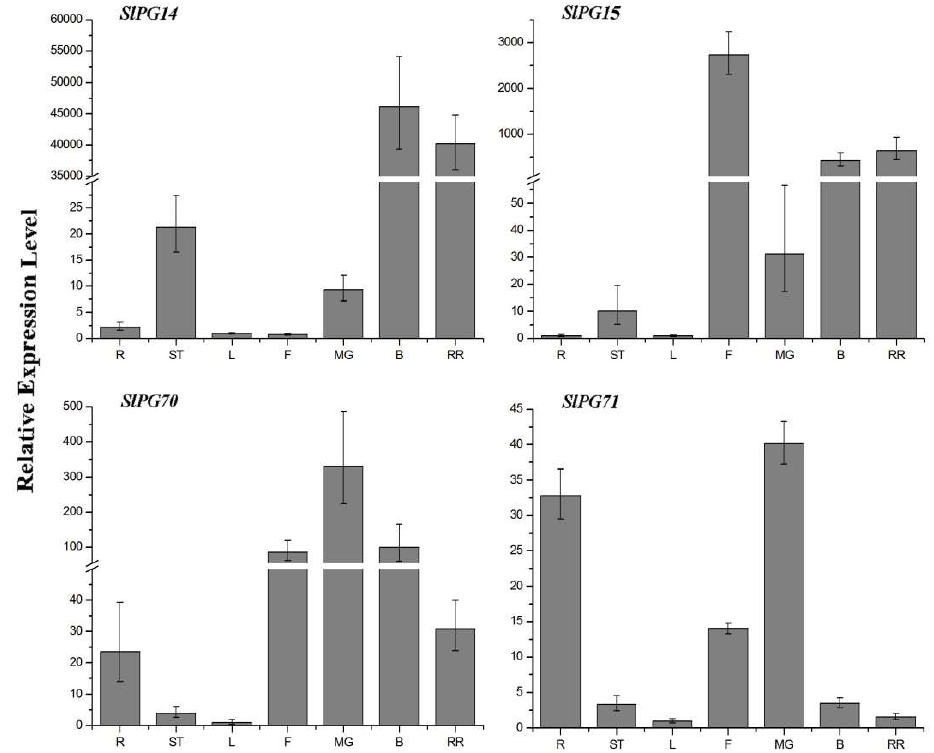
Figure 5. Detailed expression profile analysis of the four SlPG genes based on qRT-PCR analysis in different fruit developmental stages of S. lycopersicum . R: roots, ST: stems, L: leaves, F: flowers, MG: mature green fruit, B: breaker fruit, RR: red ripening fruit.